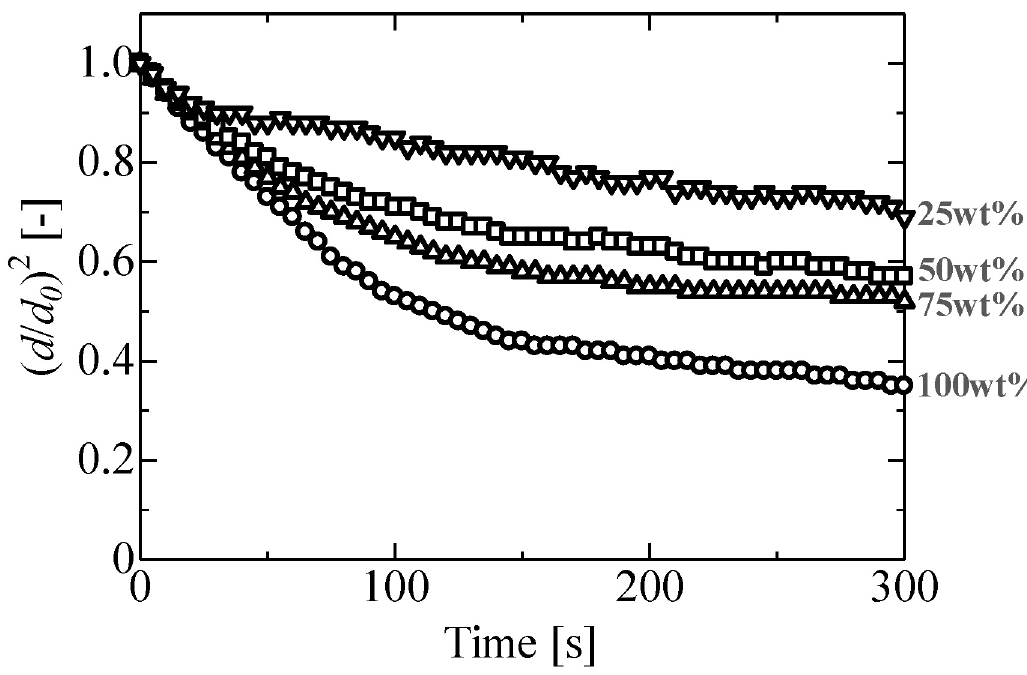
Fig 7. Evaporation process of ethanol solution droplets. 100 wt%: d 0 = 1.4 mm, P rms = 1.5 kPa, b/a = 1.7, 75 wt%: d 0 = 1.4 mm, P